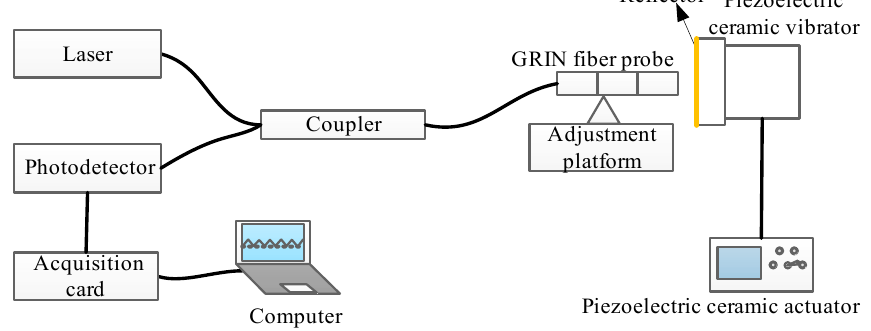
Figure 4. Schematic diagram of the experimental system of the F–P fiber interferometer.